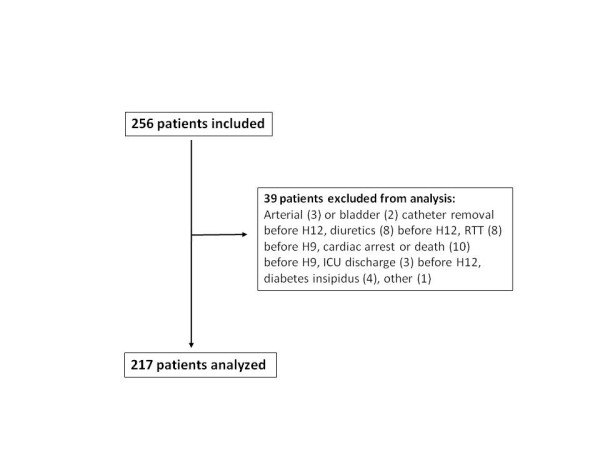
Flow diagram. RRT: renal replacement therapy.